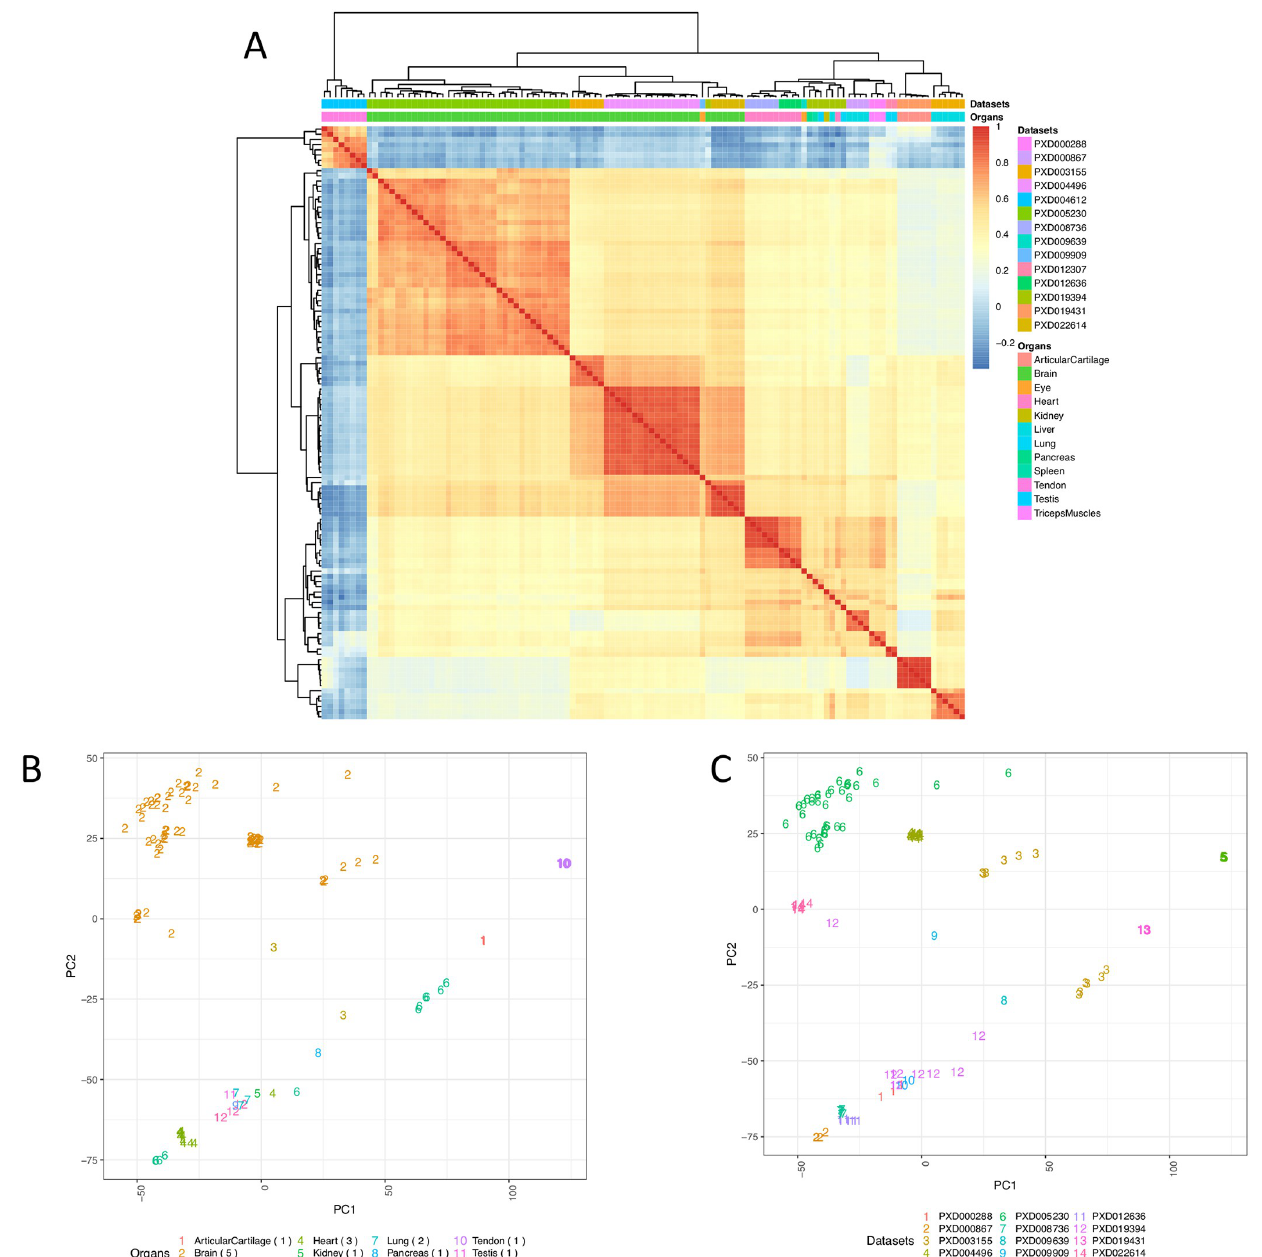
Fig 4. (A) Heatmap of pairwise Pearson correlation coefficients across all mouse samples. The colour represents the correlation coefficient and was calculated using the bin transformed iBAQ values. The samples were hierarchically clustered on columns and rows using Euclidean distances. (B) PCA of all samples, using the binned protein abundances as input, coloured by the organ types. (C) PCA of all samples coloured by their respective dataset identifiers. The numbers in parenthesis indicate the number of datasets for each organ. Binned values of canonical proteins quantified in at least 50% of the samples were used to perform the